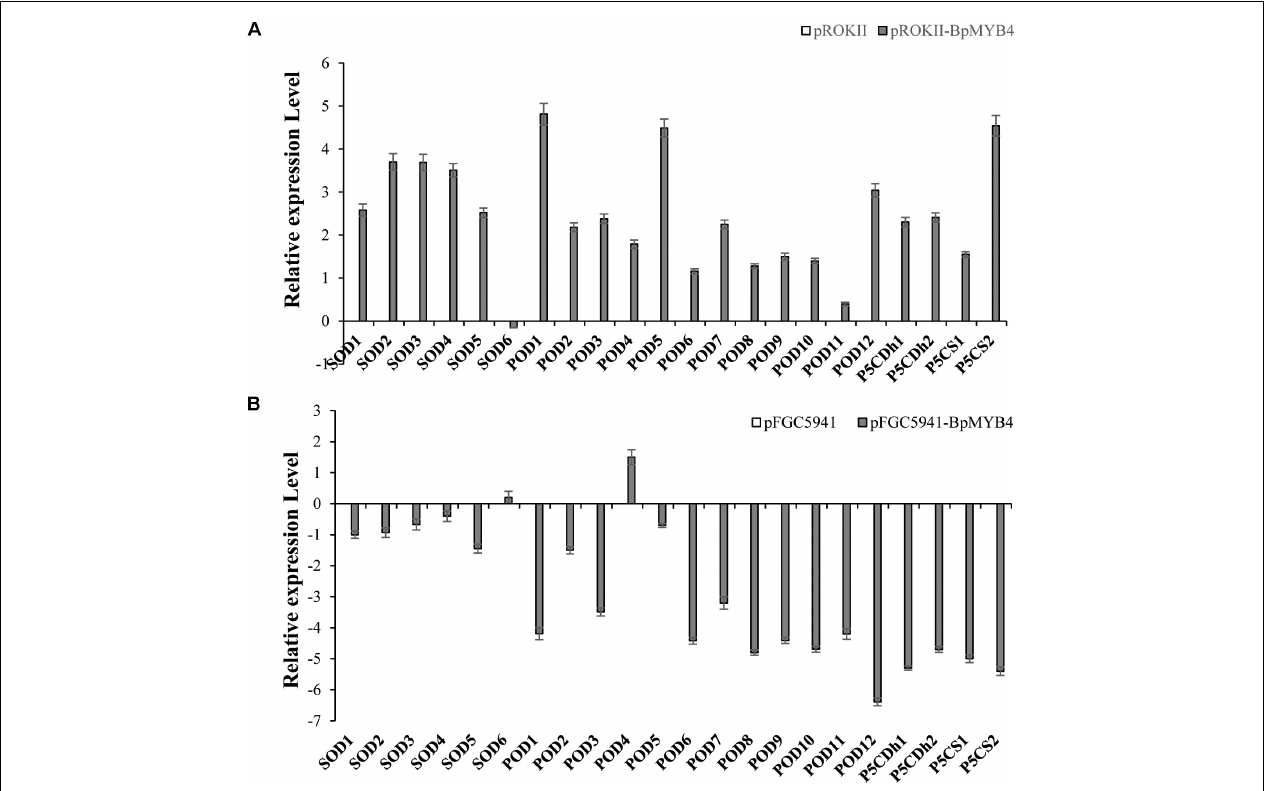
FIGURE 8 | The expression levels of resistance-related genes in overexpression and suppression of expression in birch. (A) Taking the empty vector strain (pROKII) as a control, the expression levels of resistance-related genes in overexpressing strains were monitored. (B) Taking the empty vector strain (RNAi) as a control, the expression levels of resistance-related genes in the suppressive expression line were